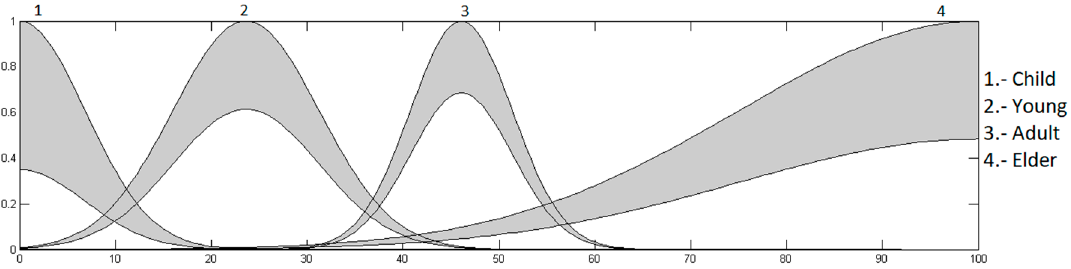
Figure 28. Optimized input age with Gaussian MFs.